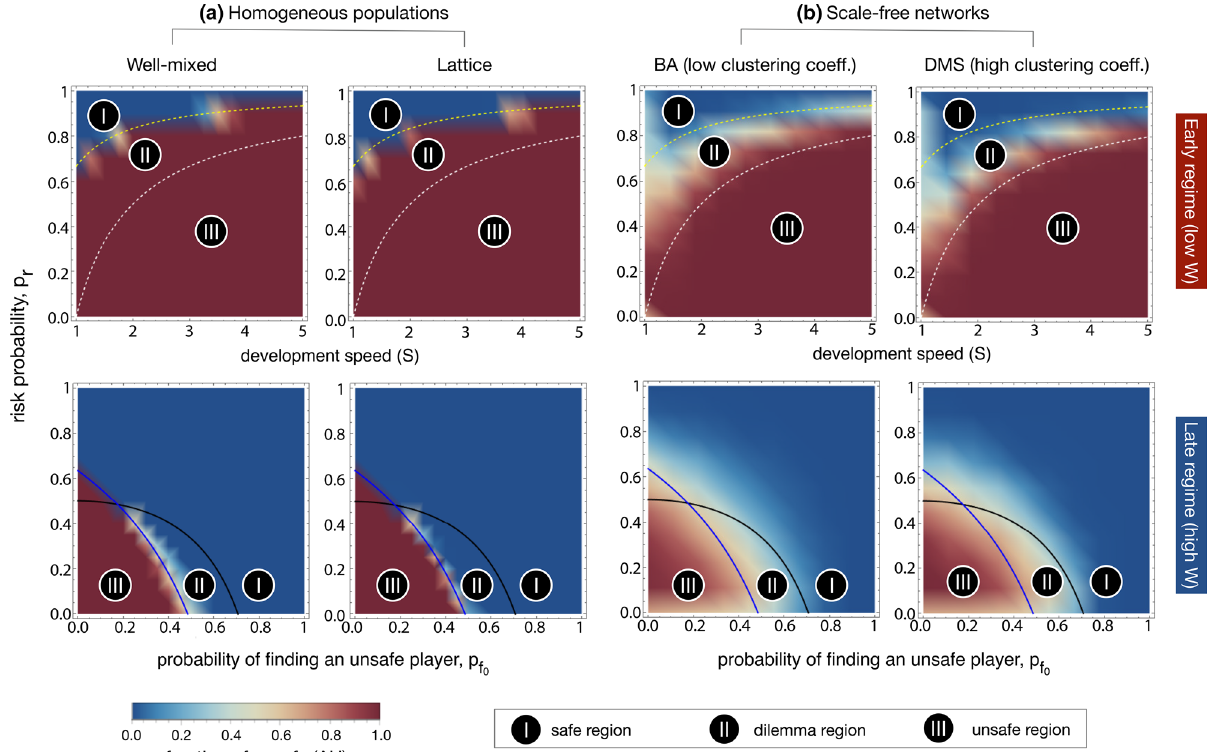
Figure 1. Color gradients indicating the average fraction of AU (unsafe strategy) for ( a ) homogeneous (well- mixed and lattices) populations and ( b ) scale-free networks (BA and DMS models). The top row addresses the early regime (low W ) for varying development speed ( s ) and risk probability ( p r ). The bottom row addresses the late regime (high W ) for varying p fo (the chances that an UNSAFE player is found out) and risk probability ( p r ). Dotted and full lines indicate the phase diagram obtained analytically 18 . In the early regime (upper panels), region II indicates the parameters in which safe AI development is the preferred collective outcome, but unsafe development is expected to emerge and regulation may be needed—thus the dilemma. In regions I and III, safe and unsafe AI development, respectively, are both the preferred collective outcomes and the ones expected to emerge from self-organization, hence not requiring regulation. In the late regime (lower panels), the solid black line marks the boundary above which safety is the preferred outcome, whereas the blue line indicates the boundary above which safety becomes risk dominant against unsafe development. The results obtained for well- mixed populations and lattices ( a ) suggest that, for both early and late regimes, the nature of the dilemma, as represented by the analytical phase diagram, remains unaltered. Moreover, homogeneous interaction structures cannot reduce the need for regulation in the early regime. Differently, we show that heterogeneous interaction structures (scale-free networks, ( b )) are able to significantly reduce the prevalence of unsafe behaviors for almost all parameter regions, including both late and early regimes. This effect is enhanced whenever scale-free networks are combined with high clustering coefficient (i.e., in the DMS model). Other parameters: p fo = 0.5 , and W = 100 (top panels); s = 1.5 and W = 10 6 (bottom panels); c = 1 , b = 4 , B = 10 4 , and β = 1 , in all